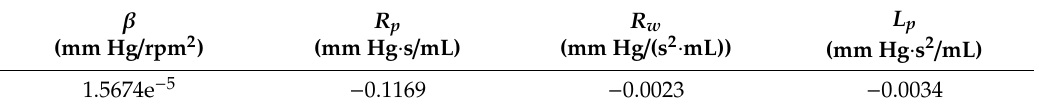
Table 2. Hydraulic performance model coe ffi cient of the blood pump.